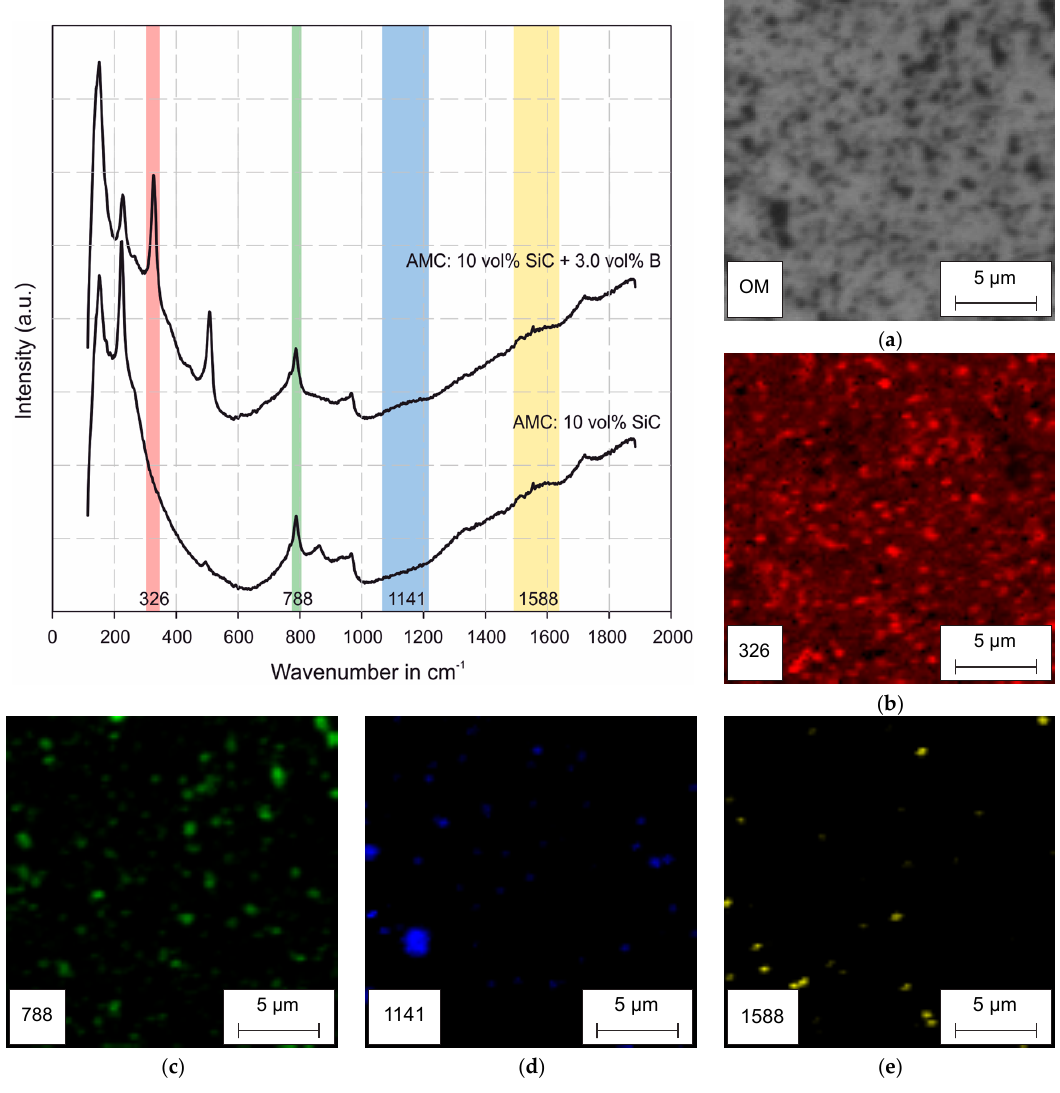
Figure 7. Raman mapping at an AMC with 10 vol % SiC and 3 vol % B and the averaged single spectra of the sample and the reference AMC with 10 vol % SiC; ( a ) optical micrograph of measuring area for mapping by bands: ( b ) at 326 cm − 1 for Al 3 BC, ( c ) at 788 cm − 1 for SiC, ( d ) at 1141 cm − 1 for boron, and ( e ) 1588 cm − 1 for carbon.